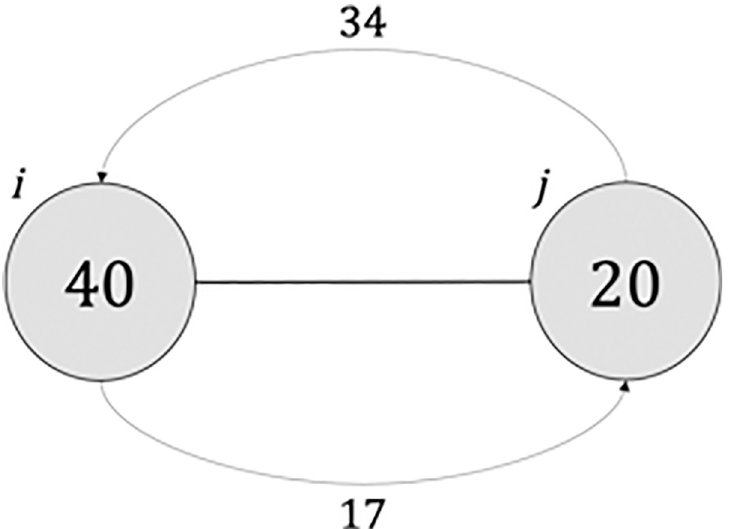
Fig 1. Example of age-distance computation for an illustrative